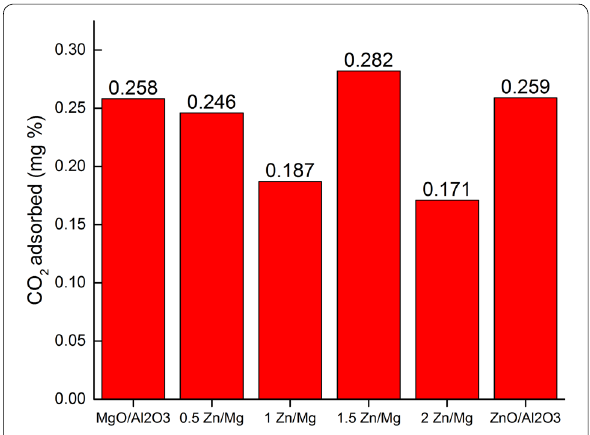
Fig. 2 Results of CO 2 adsorption for the prepared catalysts